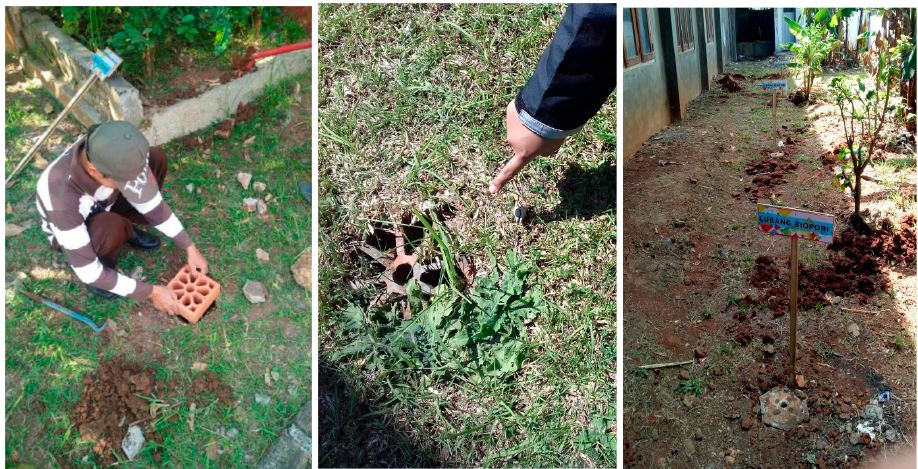
Figure 3. Biopore at installation (left) and existing biopores in the vicinity of Padangsari provincial government office (middle and right) (Source: Januarta Dwi Kusmayanti and Sheila Nabila).